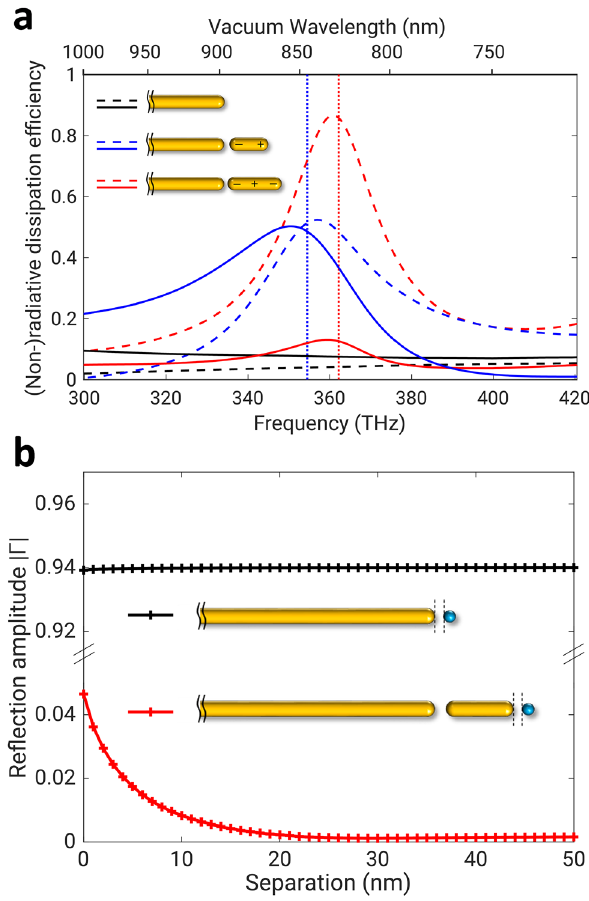
Figure 4: (a) Radiative (solid lines) and non-radiative (dashedlines) dissipation efficiency of gCPA-driven nanorod at the first-order (blue) and second-order resonances (red). The radiative and non- radiative dissipation efficiencies of the open end of a semi-infinite wire are also plotted for reference (black). The vertical dotted lines indicatethegCPAfrequenciesforfirstandsecondorderresonances. Legends also include the charge distribution on the nanorods for first-order and second-order resonances. (b) Comparison of the reflection amplitude to a local perturbation (approaching dielectric sphere,diameter20nm)ofasimplewiresensor(black)comparedto a gCPAwire – rodsensor(red).Forthelatter, apronouncedchangein re fl ection amplitude is observed for separations below 10 – 20